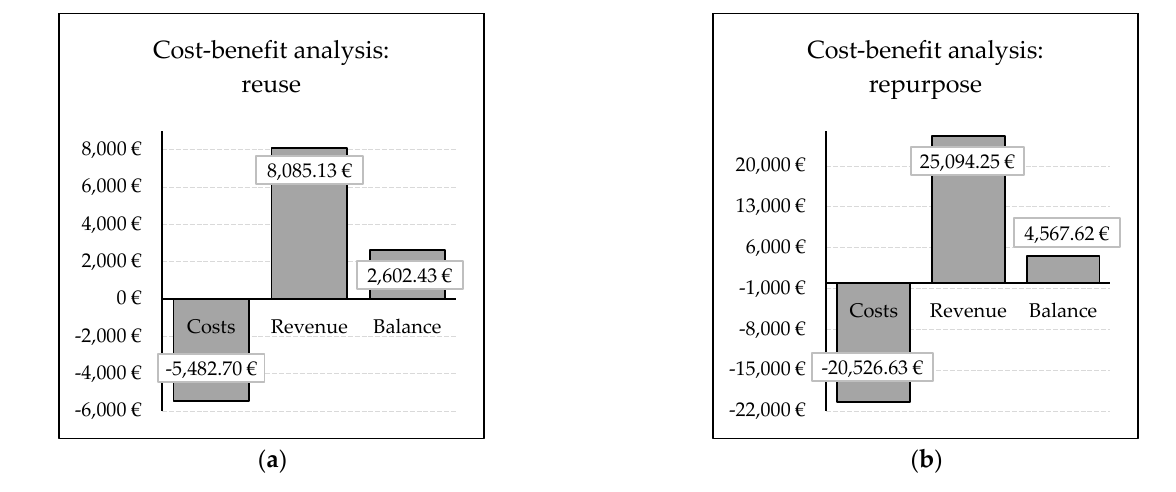
Figure 10. Cost – benefit analysis of the business case related to a processed battery pack for ( a ) reuse and ( b ) repurpose (non-scaled state-of-the-art process design).